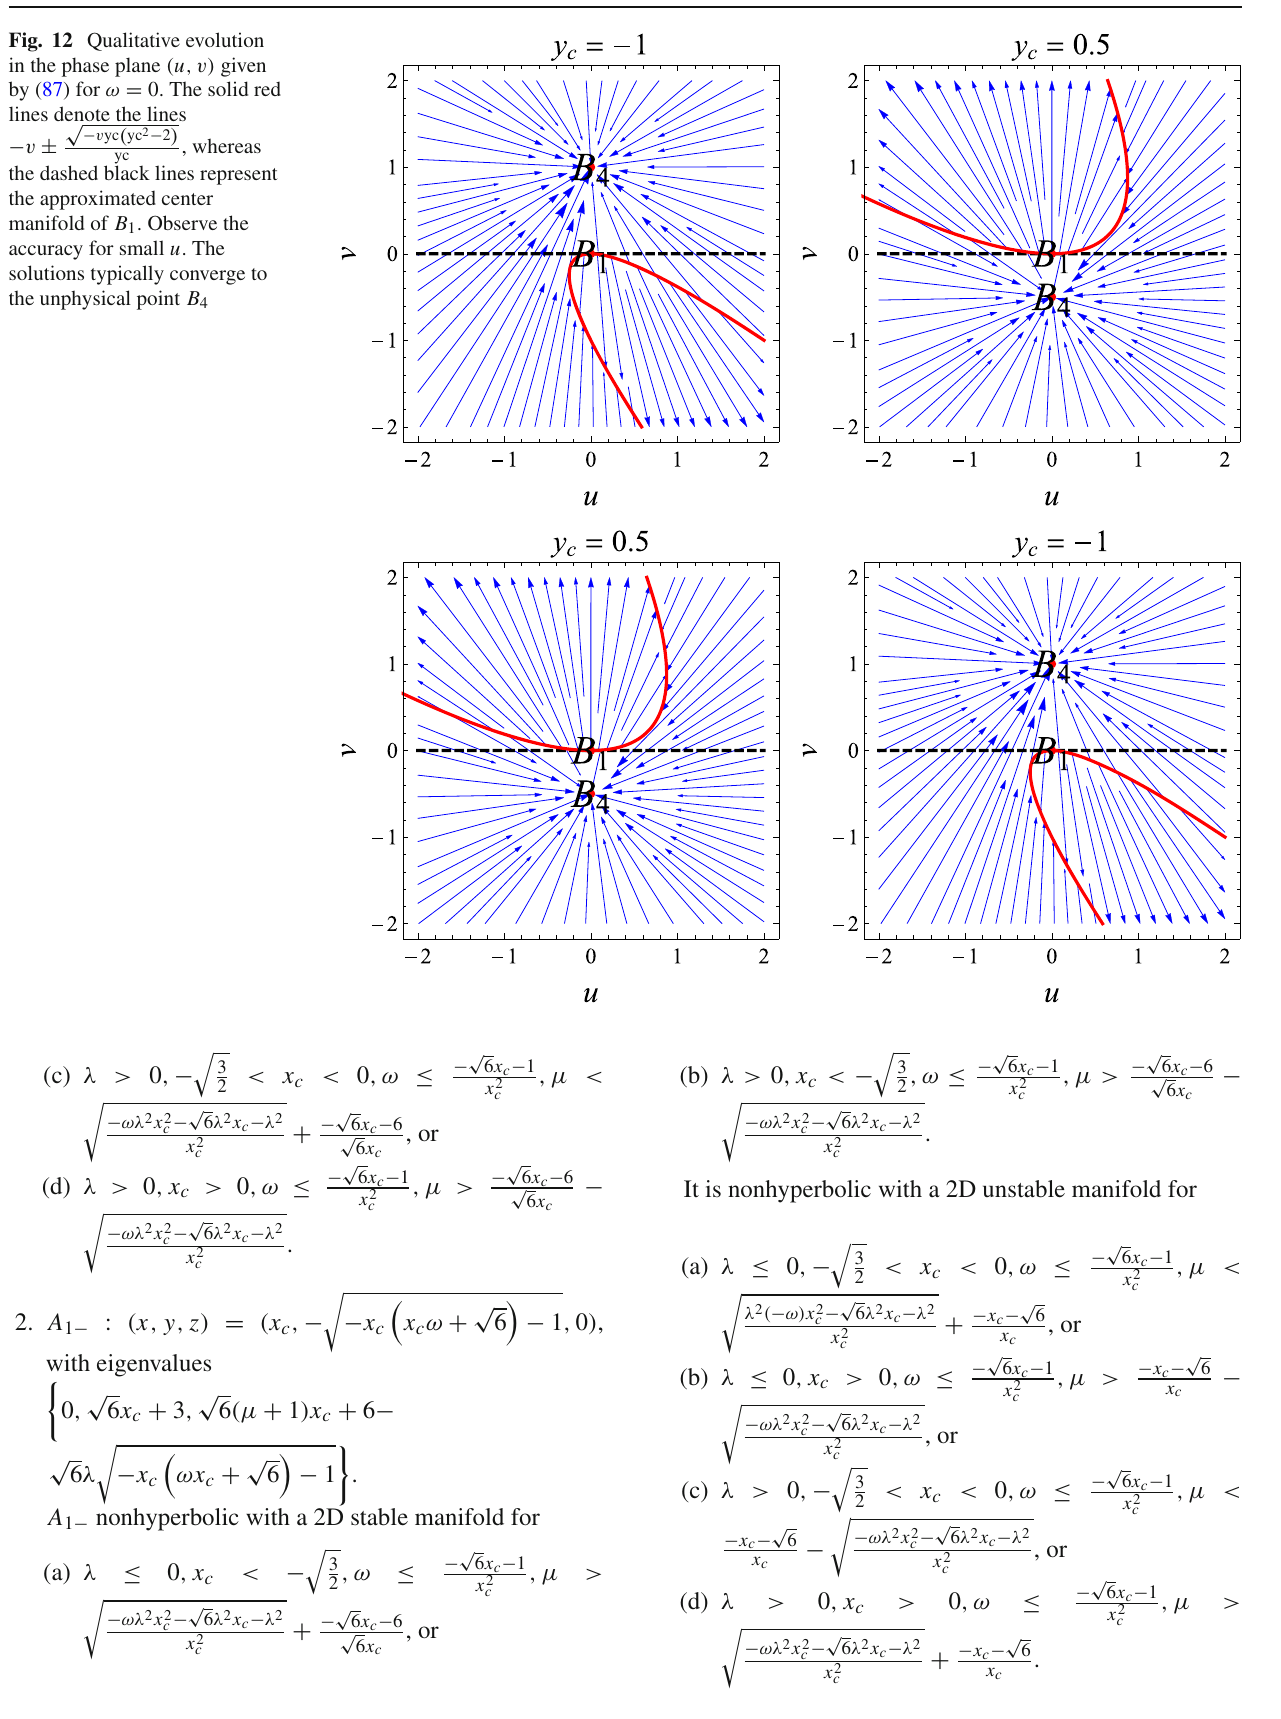
Fig. 12 Qualitative evolution in the phase plane ( u ,v) given by (87) for ω = 0. The solid red √ lines denote the lines − v yc ( yc 2 − 2 ) − v ± , whereas yc the dashed black lines represent the approximated center manifold of B 1 . Observe the accuracy for small u . The solutions typically converge to the unphysical point B